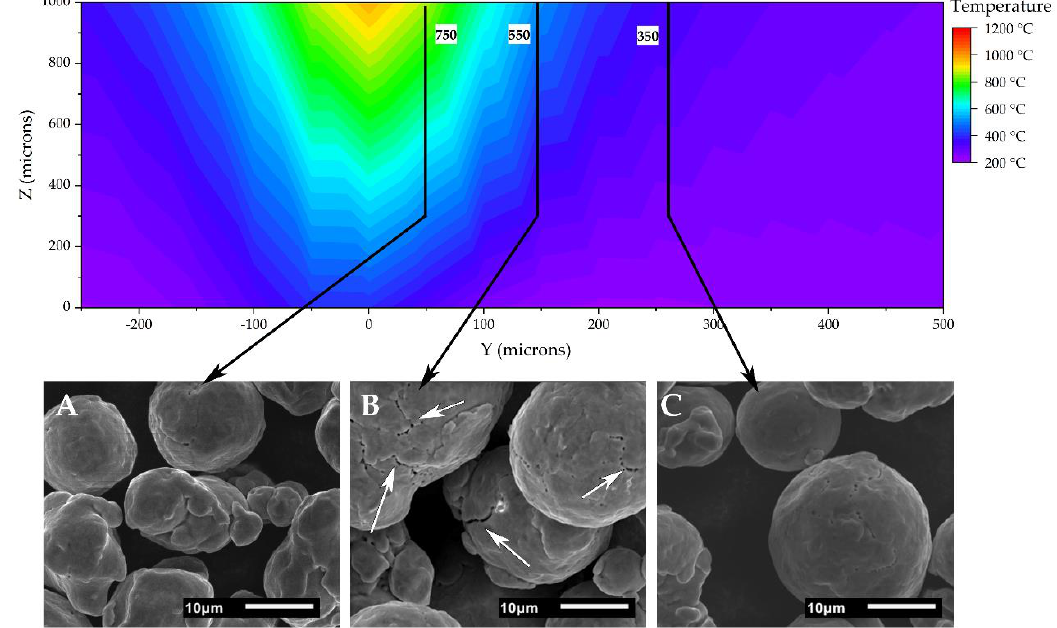
Figure 12. Contour plot of the temperature profile in the XZ plane during melting, with a 2000 µm hatch spacing, showing SEM images of particles located at the edge/wall ( A ), ~0.1 mm ( B ), and ~0.3–0.5 mm ( C ) from the wafer.